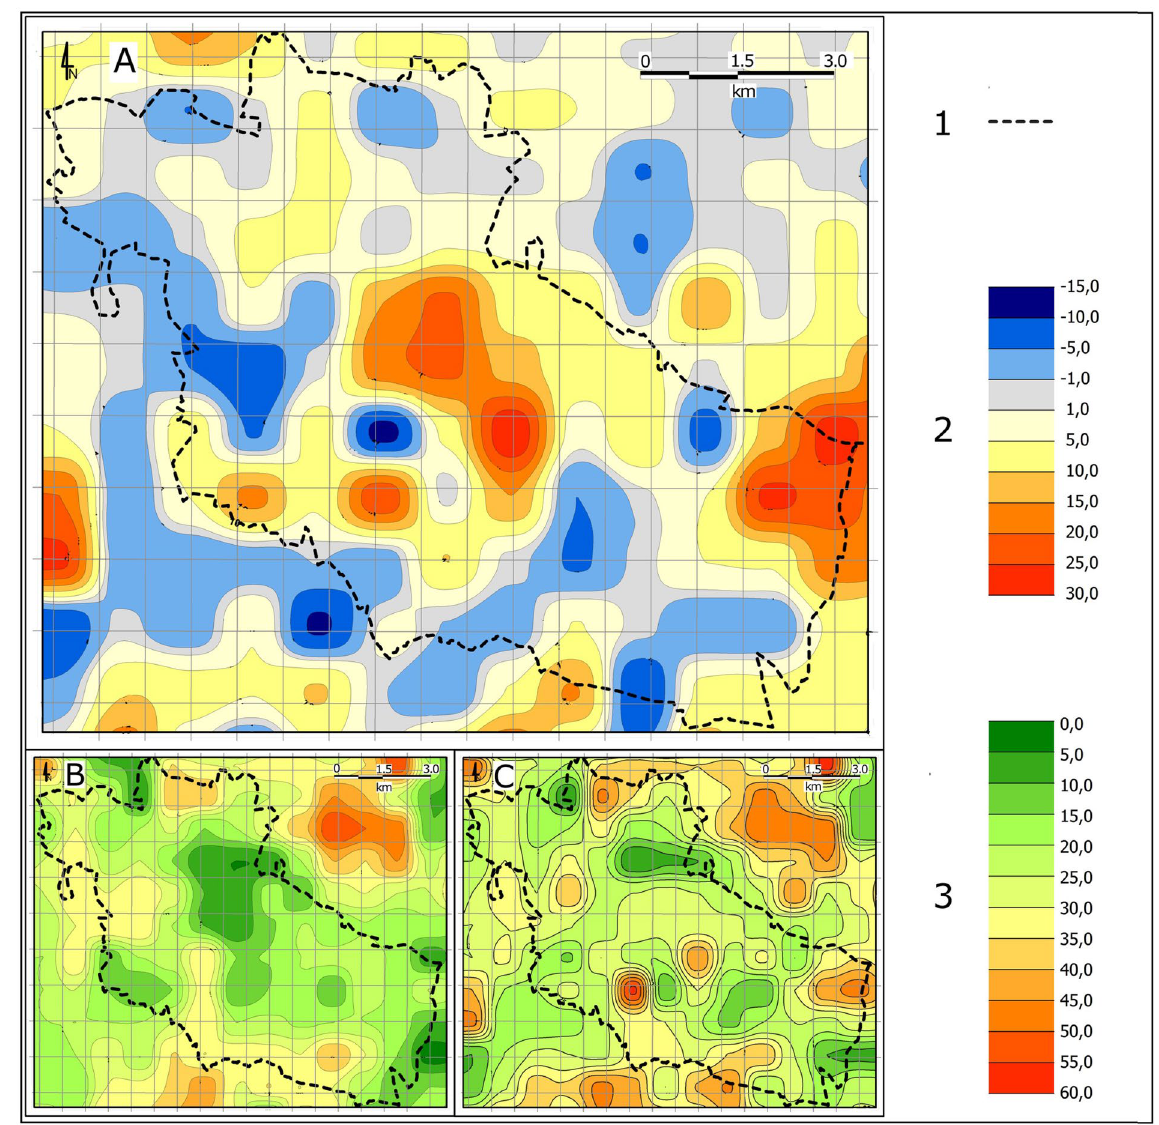
Figure 7. Changes in Bytom’s relief intensity in the nineteenth and twentieth centuries: A—changes in relative elevation from the late nineteenth century to the late twentieth century; B—variation in relative elevation in the late nineteenth century; C—variation in relative elevation in the late twentieth century; 1—city boundary; 2—magnitude of change in relative elevation from the late nineteenth century to the late twentieth century; 3— variation in relative elevation from the late nineteenth century to the late twentieth